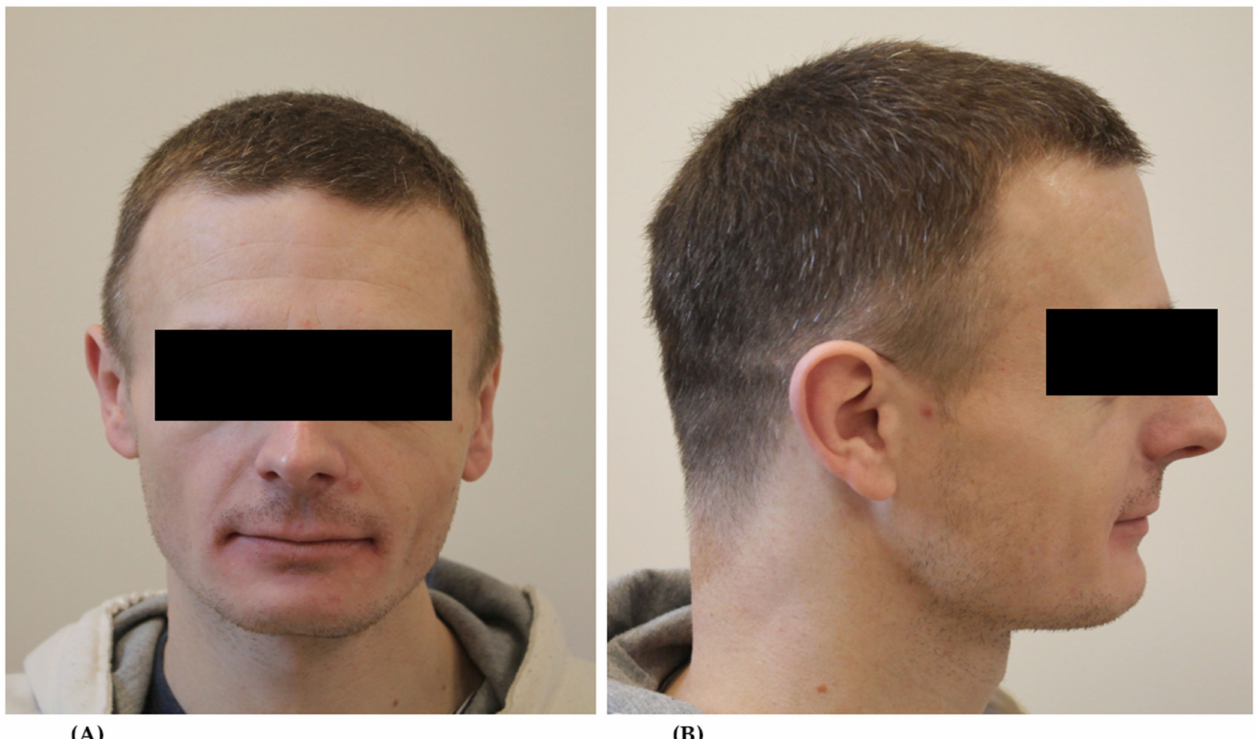
Figure 1. Head and face ( A ) and lateral head ( B ) photography: long philtrum, low-set ears, dolichocephaly, retrogenia, and microgenia.